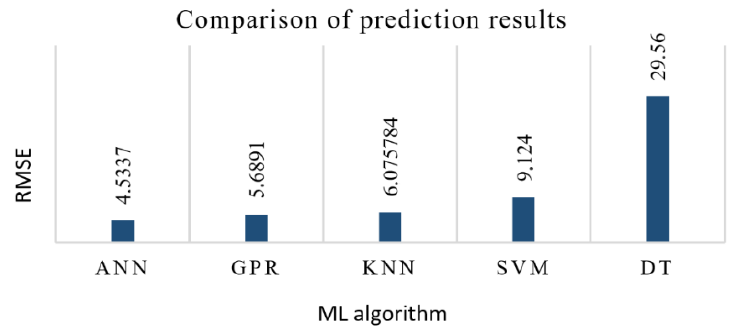
Figure 20. Comparison of different ML algorithm prediction error results.